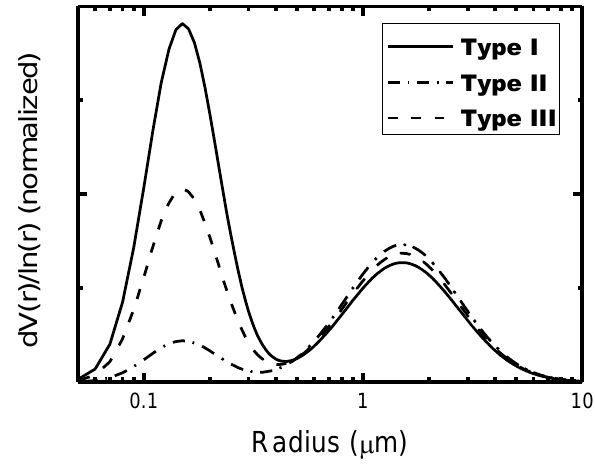
Fig. 1. Normalized size distributions used for computing the simu- Figure 1: Normalized size distributions used for computing the simulated optical data. The ratio lated optical data. The ratio between the volume of fine and coarse between the volume of fine and coarse mode, V mode, V tc /V tc , is 2 for type I, 0.2 for type II and 1 for type III.